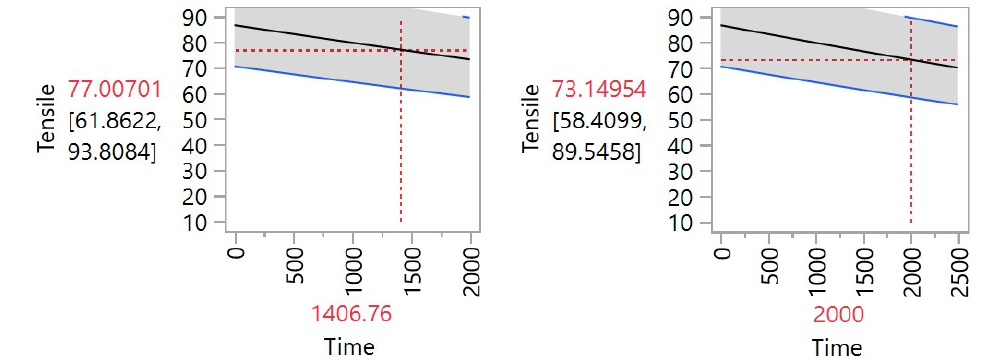
Figure 3. Degradation prediction for tensile ( left ) for 10% and ( right ) for 2000